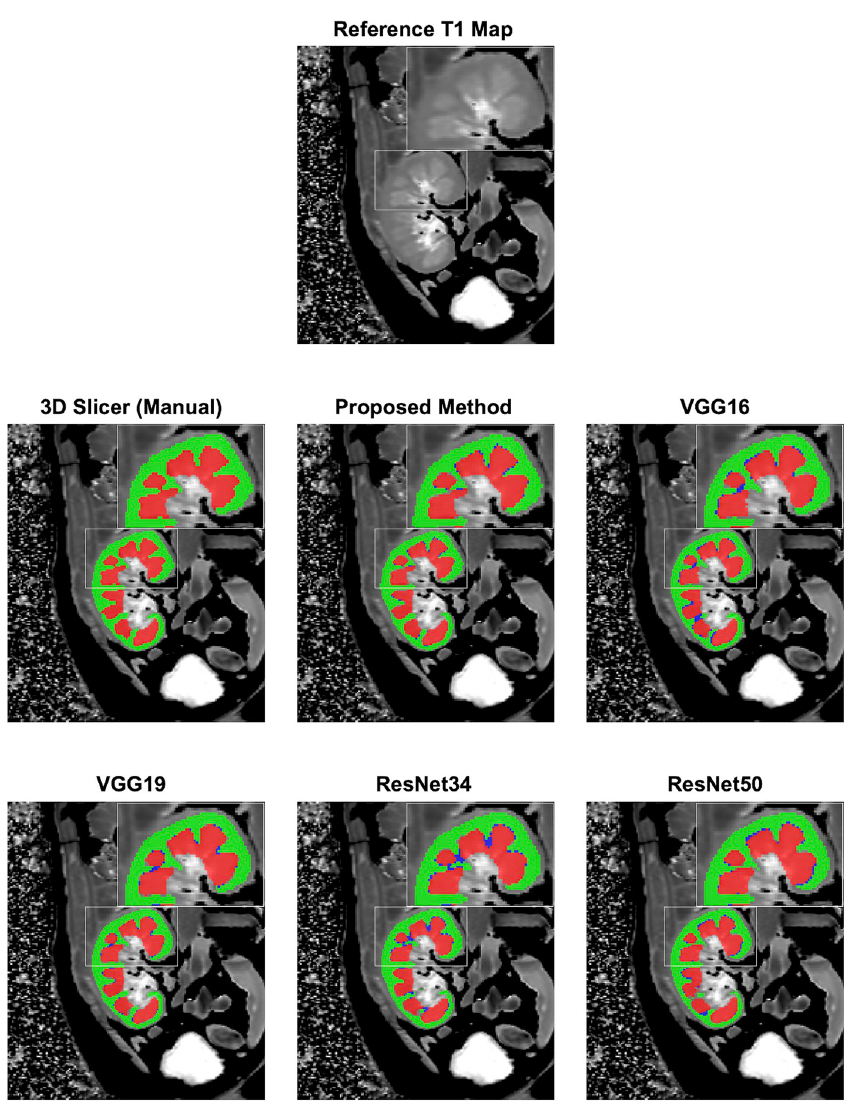
Fig 2. Predicted cortex (Green)and medulla (Red) masks registered over reference T1 map. Segmentation leakage (Blue) is a mixed portion of both cortex and medulla in segmentation provided by the all CNNs. The results show that the proposed RCM U-Net gives better segmentation results as compared to conventional CNNs i.e. VGG16 [15], VGG19 [17], ResNet34 [18], and ResNet50 [19] with U-Net as the backbone. Also, the conventional CNNs have more leakage segmentation than the proposed RCM U-Net as shown in zoomed